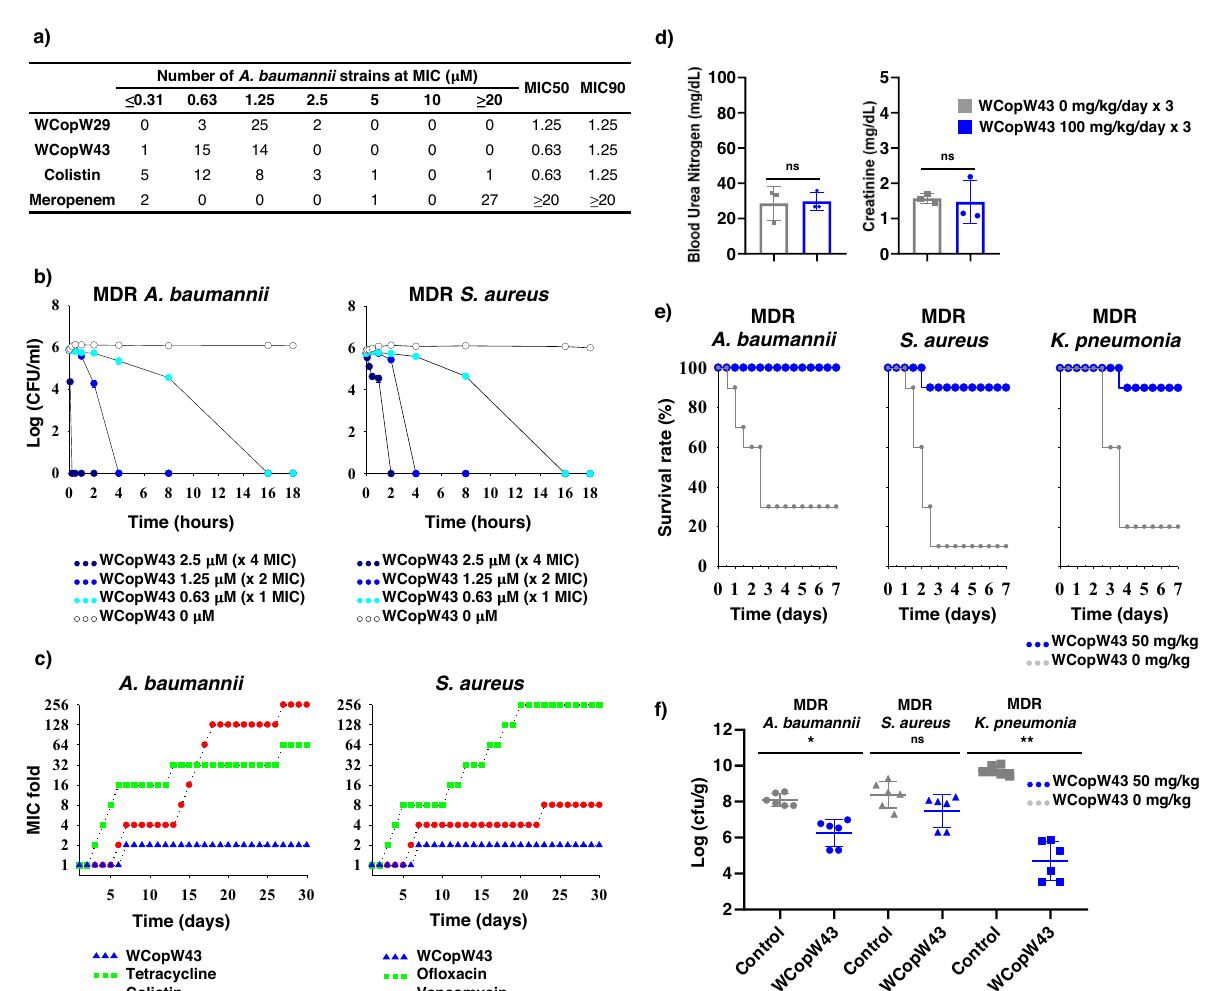
Fig. 4 WCopW43 is a potential next-generation AMP. a The MIC50 and MIC90 values for WCopW43 against 30 A. baumannii strains, including 27 carbapenem-resistant strains, indicate that it has a broad spectrum breakpoint MIC against MDR strains, including colistin-resistant strains (Supplementary Table 6). b The antimicrobial kinetics of MDR Gram-negative and Gram-positive bacteria indicate that WCopW43 kills both types at MIC concentrations. c Analysis of non-resistant Gram-negative and Gram-positive bacteria exposed to MIC and sub-MIC concentrations WCopW43 for 30 days indicates emergence of WCopW43 resistance is suppressed. Stable antibiotics and stereospeci fi c antibiotics were used as controls. d Nephrotoxicity indicators in a mouse model. WCopW43 (100 mg/kg) or PBS was subcutaneously injected into BAKB/c mice daily for 3 days. Groups were statistically compared using unpaired t tests (* P < 0.05, ** P < 0.01, ns: not signi fi cant). e Survival rates among infected mice. BALB/c mice were subcutaneously infected with MDR A. baumannii (1 × 10 8 cfu/ml), MDR S. aureus (1.5 × 10 8 cfu/ml) or MDR K. pneumonia (1 × 10 9 cfu/ml). One hour later, the mice were subcutaneously administered WCopW43 (50 mg/kg) or PBS. f CFU kinetics of the mouse model. From among the mice in the survival experiment, three were randomly selected. One day after infection, tissue was collected, processed and spread to count CFUs. CFU numbers were statistically compared using unpaired t tests.